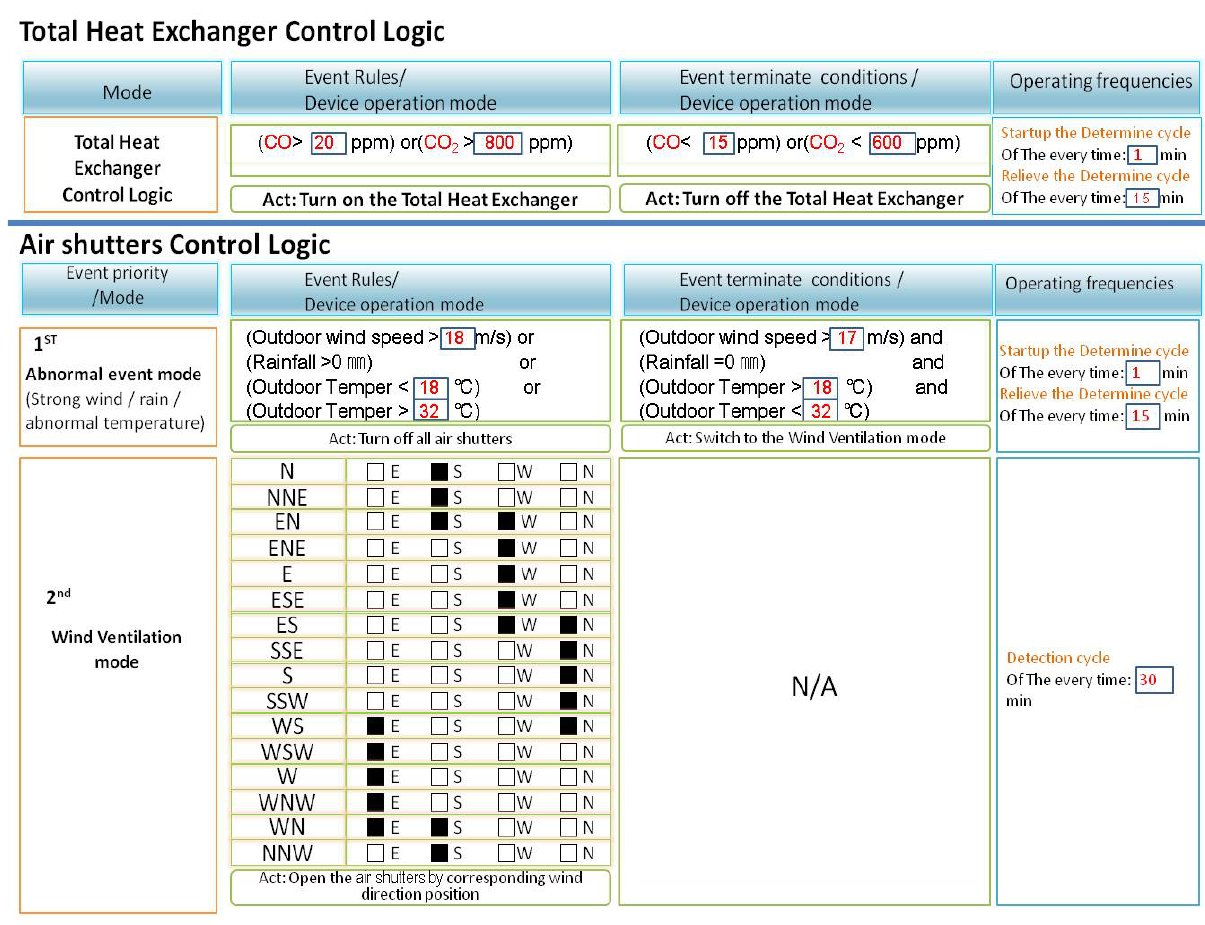
Figure 9. The logic control model includes health and comfort indicators and equipment actuation constraint